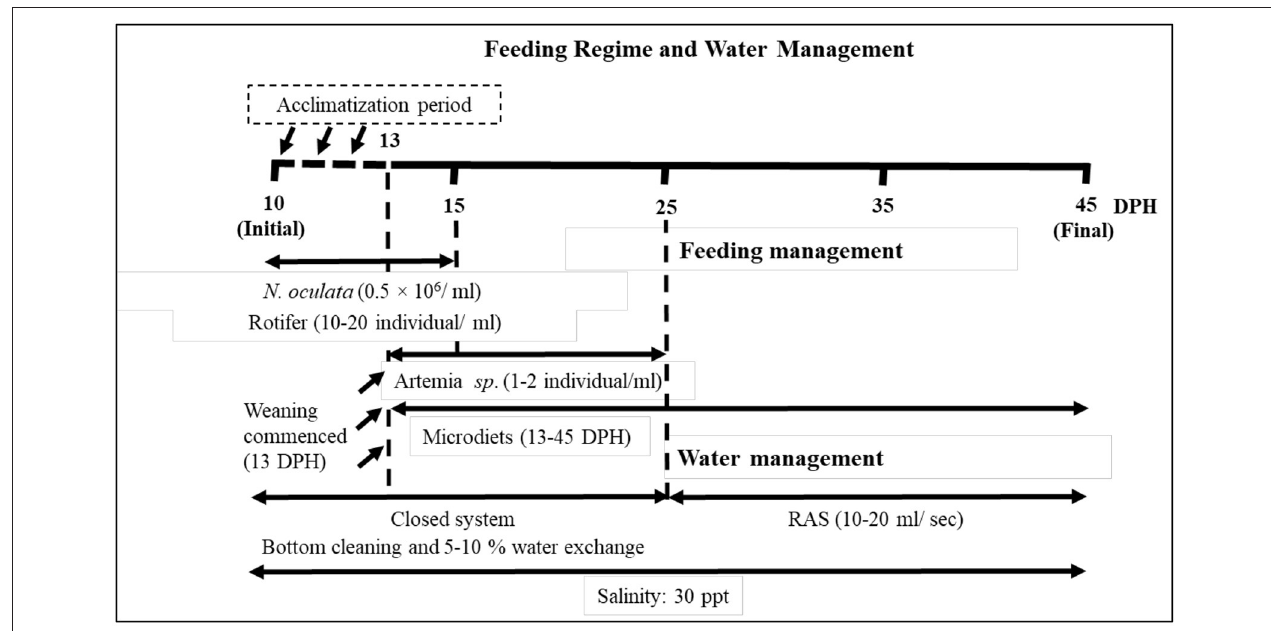
FIGURE 1 | Feeding regime and water management.